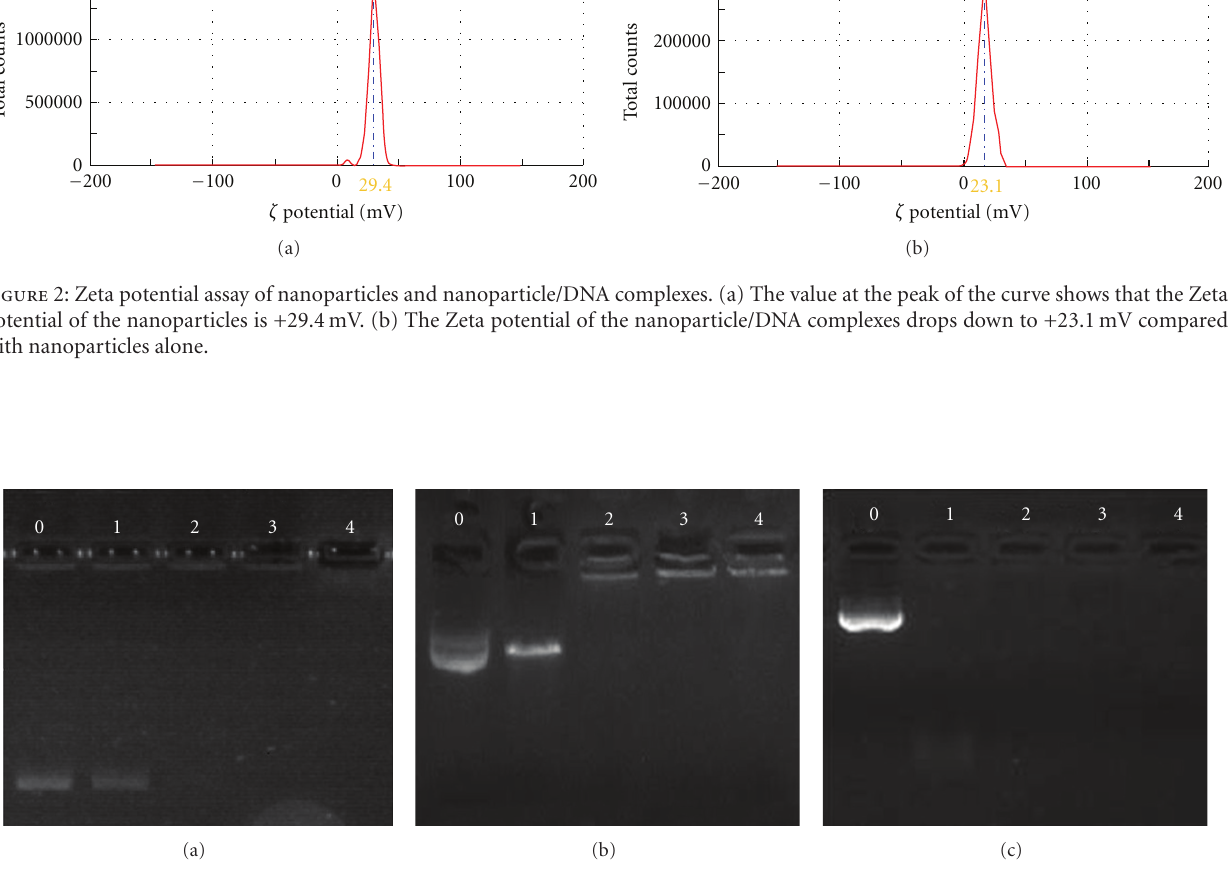
Figure 3: Agarose gel electrophoresis of plasmid DNA and nanoparticle/DNA complexes: (a) Lane 0: pure plasmid (control); lanes 1 ∼ 4: nanoparticle/DNA complexes at the ratio of 1:20, 1 :10, 1:5, and 1 :1, respectively. (b) Lane 0: pure plasmid; lane 1: plasmid digested with Eco R I; lanes 2 ∼ 4: nanoparticle/DNA complexes at the ratio of 1:10, 1: 5, and 1:1, respectively, digested with Eco R I. (c) Lane 0: pure plasmid; lane 1: plasmid digested with DNase I; lanes 2 ∼ 4: nanoparticle/DNA complexes at the ratio of 1 :10, 1:5, and 1 :1, respectively, digested with DNase